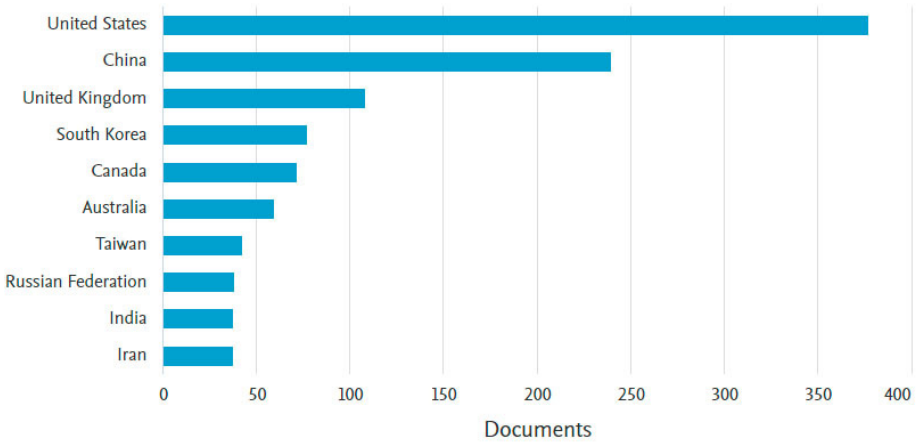
Buildings 2023 , 13 , x FOR PEER REVIEW Figure 4. Documents per top 10 authors (Scopus, 2022). Figure 4. Documents per top 10 authors (Scopus, 2022) . Figure 4. Documents per top 10 authors (Scopus, 2022) .